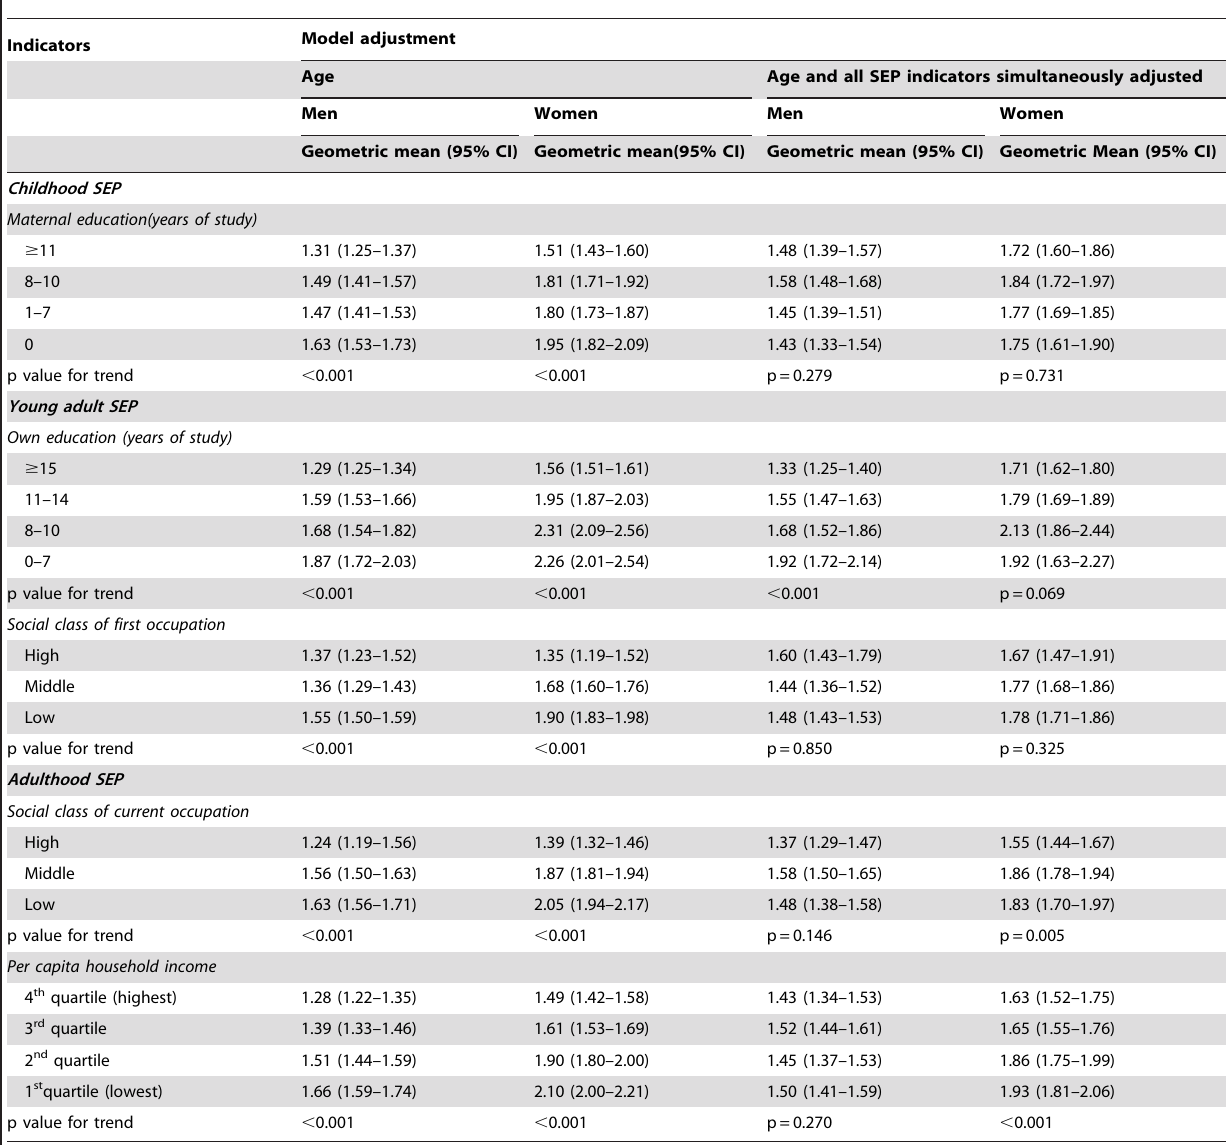
Table 4. Adjusted geometric means (95% confidence interval) for levels of CRP by SEP indicators throughout the life